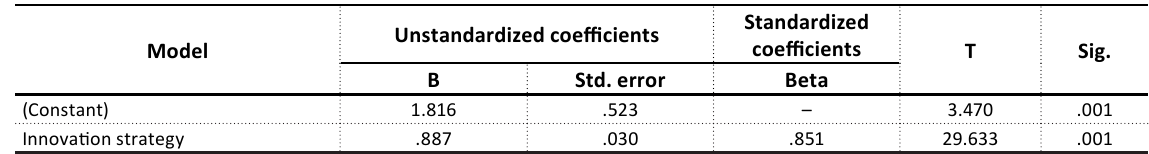
Source: Computed from survey data